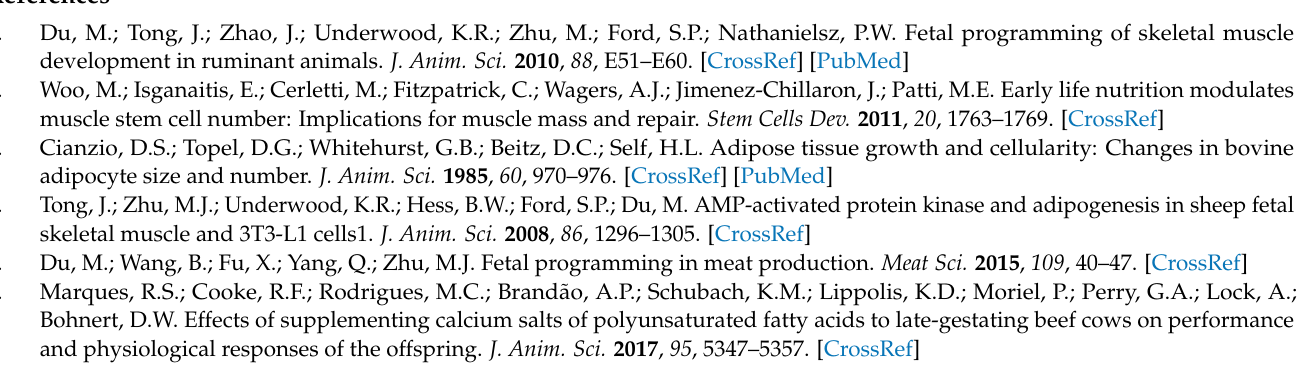
Table S2: qPCR performance of the genes analyzed in adipose